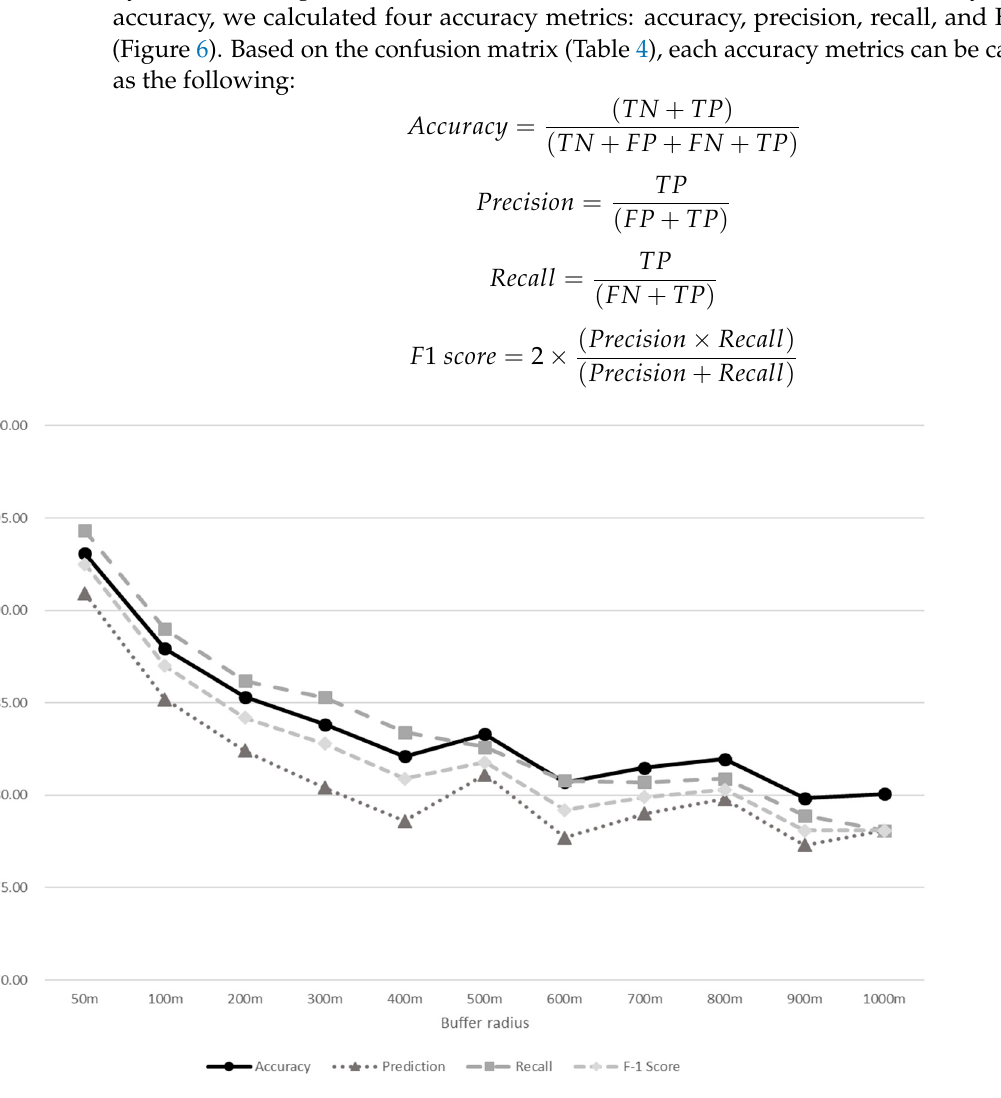
Table 4. Confusion matrix .